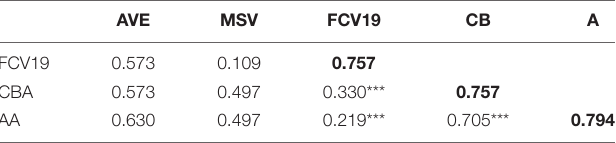
TABLE 6 | Fornell-Larcker criterion